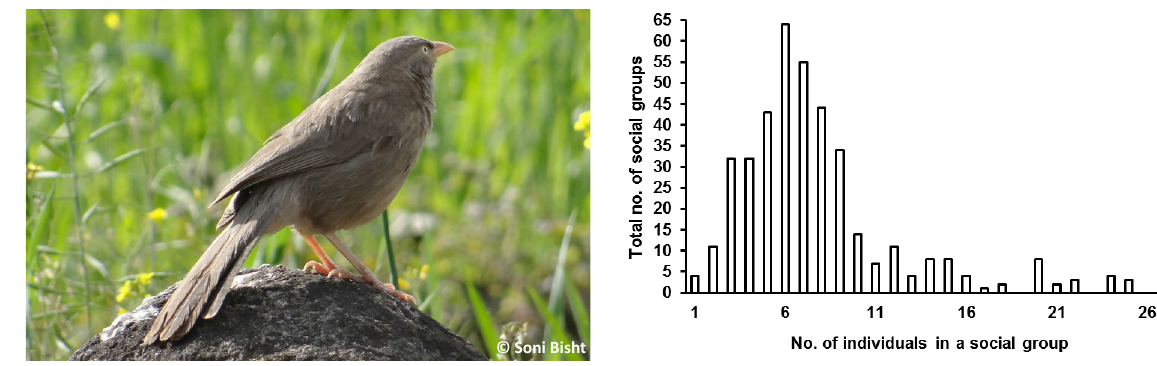
Figure 1. The number of individuals documented within the observed social groups (n=400) of Jungle Babblers through the web- based